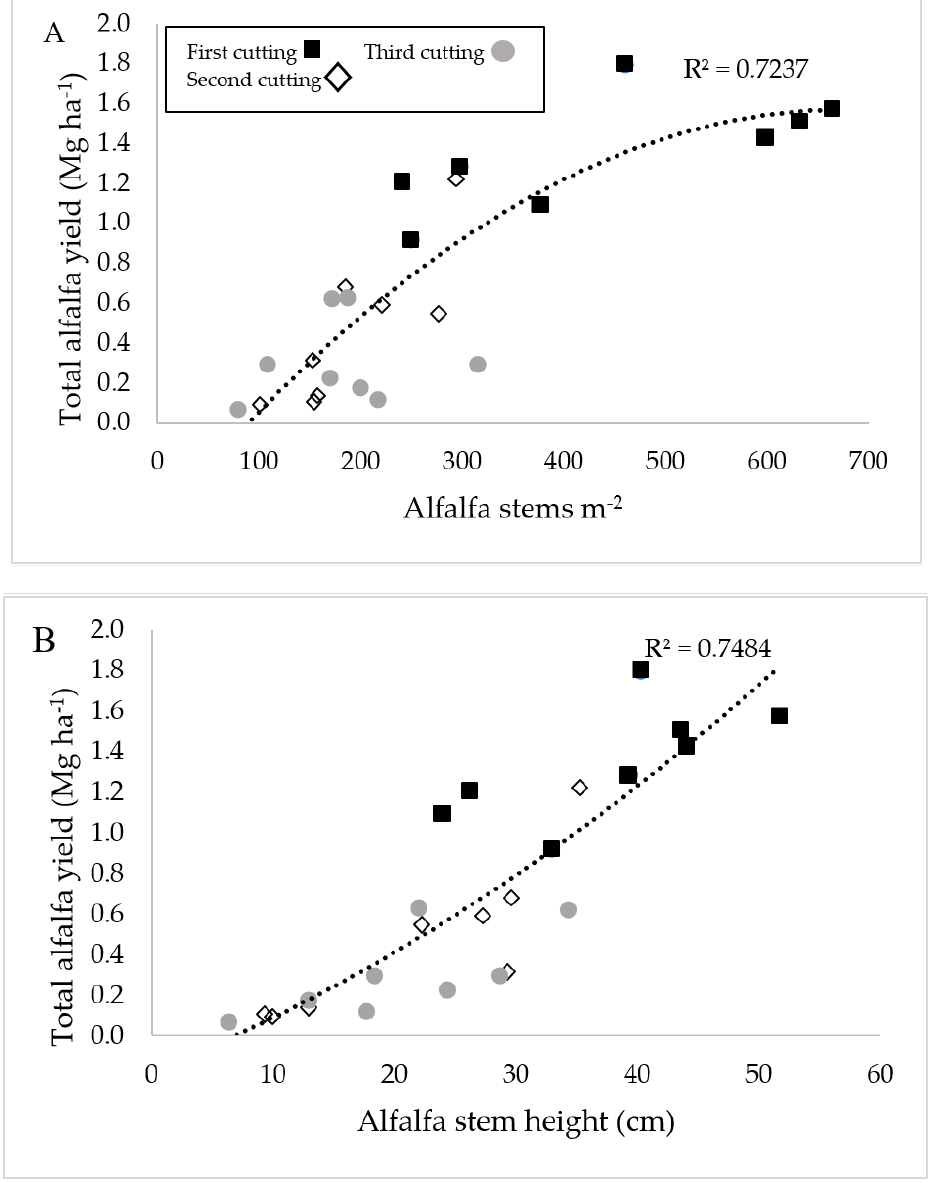
Figure 4. Second-order polynomial regression of alfalfa yield (Mg ha − 1 ) against ( A ) alfalfa stem density (no. m − 2 ) and ( B ) alfalfa stem height (cm), at each harvest in the seeding year of both experiments in studies started in 2016 and 2017 at Boone, IA,